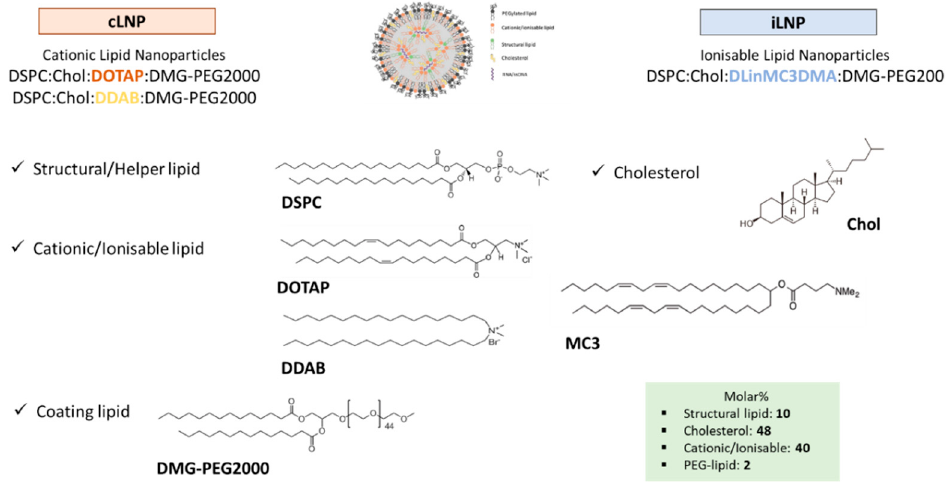
Figure 1. Lipid nanoparticles selected for optimisation. Cationic lipid nanoparticles (cLNPs) are based on either the cationic lipid DOTAP or DDAB, whereas ionisable lipid nanoparticles (iLNPs) are based on the ionisable lipid DLin-MC3-DMA. All described formulations contain DSPC and cholesterol as structural lipids and DMG-PEG2000 as the coating lipid. Unless otherwise stated, the lipid molar ratio used was 10:48:40:2 for DSPC:cholesterol:cationic / ionisable:PEG-lipid. The molecular structures of each component are shown in the figure along with the schematic representation of the structure of a lipid nanoparticle loaded with nucleic acids.